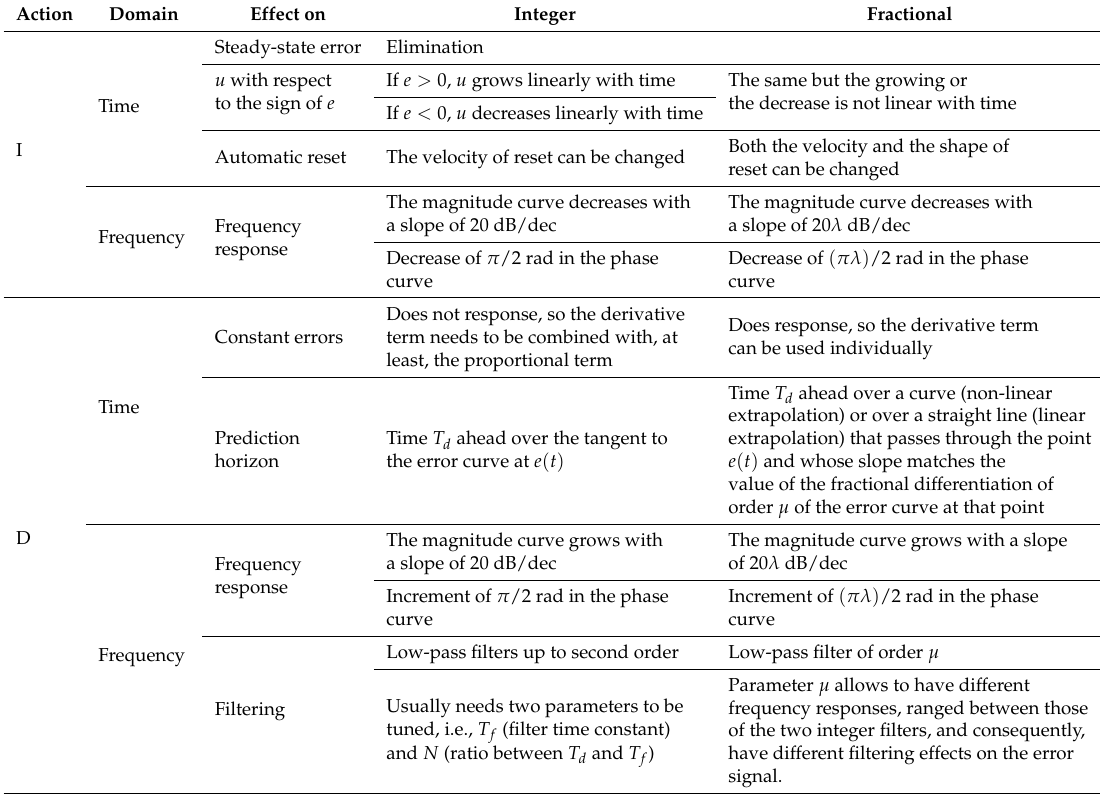
Table 1. Similarities and differences between classical and fractional proportional-integral-derivatives (PID)